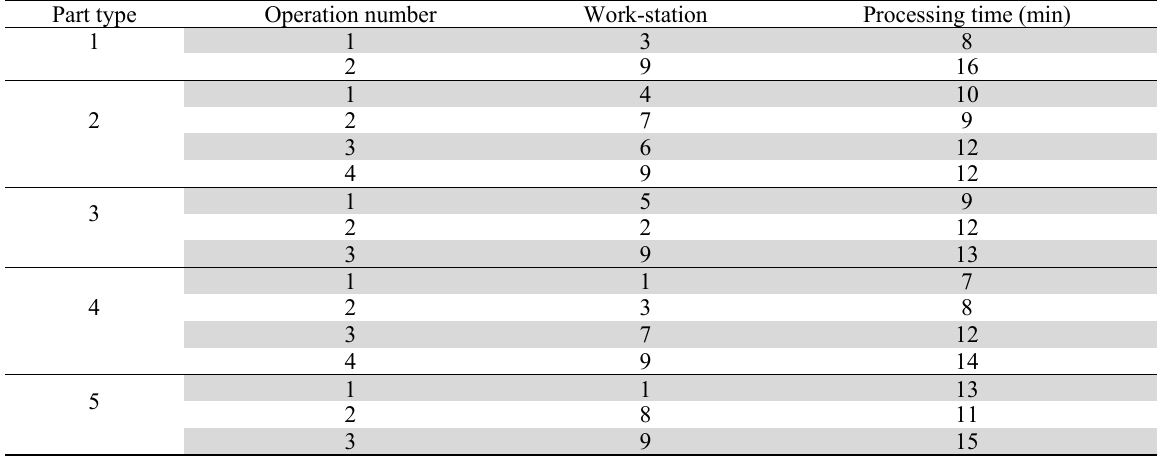
Part type routing and manufacturing characteristics for the FMS layout 3 Part type Operation number Work-station Processing time